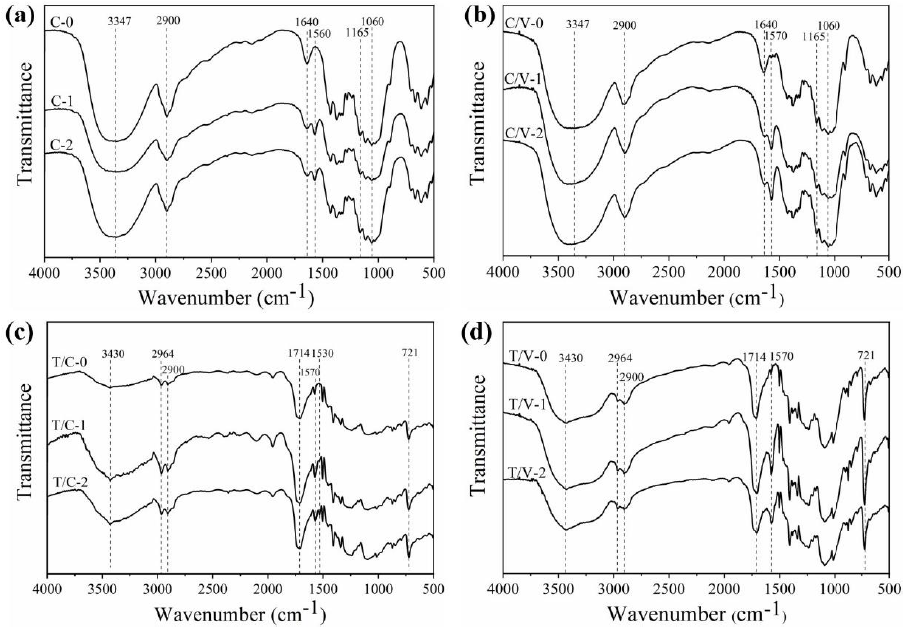
Figure 10. The FTIR spectra of original and treated fabrics with dipping and pad–dry–cure processes.